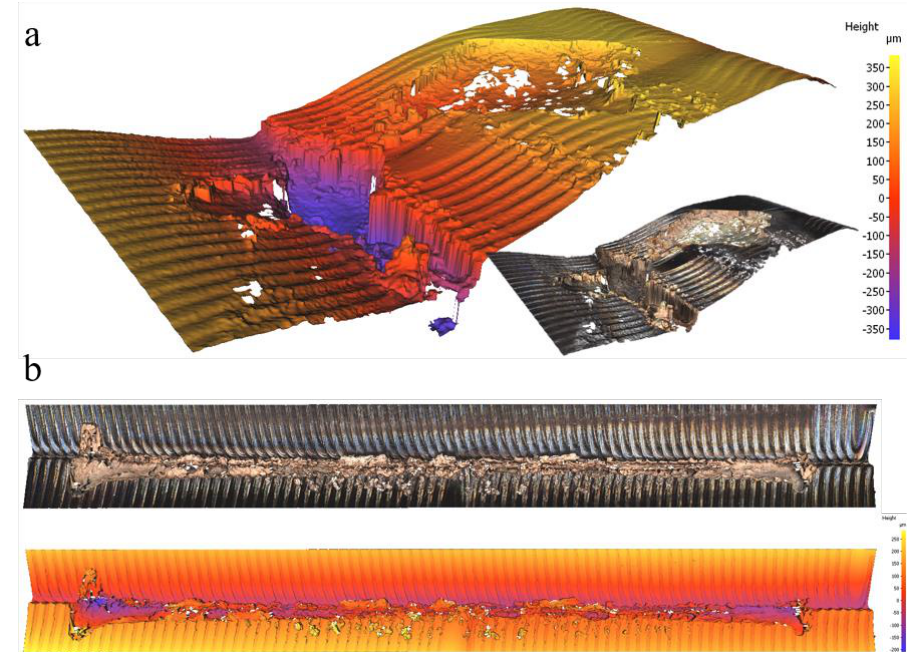
Figure 16. Representative 3D reconstructions of localized crevice corrosion on sample B2 after the PDP test: ( a ) initiation point; and ( b ) whole surface.